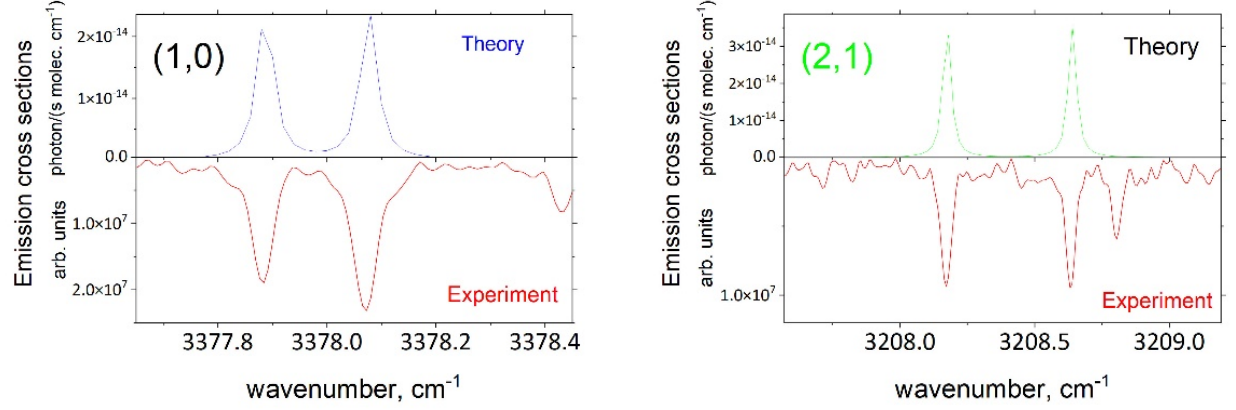
Figure 9. Theoretical emission spectra of OH (1,0 and 2,1) simulated using the MoLLIST line list ( T rot = 500 K and T vib = 3620 K, using a Lorentzian line profile of HMHM = 0.02 cm − 1 ) with the ( 𝑇 (cid:2928)(cid:2925)(cid:2930) = 500 K and 𝑇 (cid:2932)(cid:2919)(cid:2912) = 3620 K, using a Loren tz ian line pro fi le of HMHM = 0.02 cm − 1 ) with the experimental spectrum from this experimental spectrum from this work.